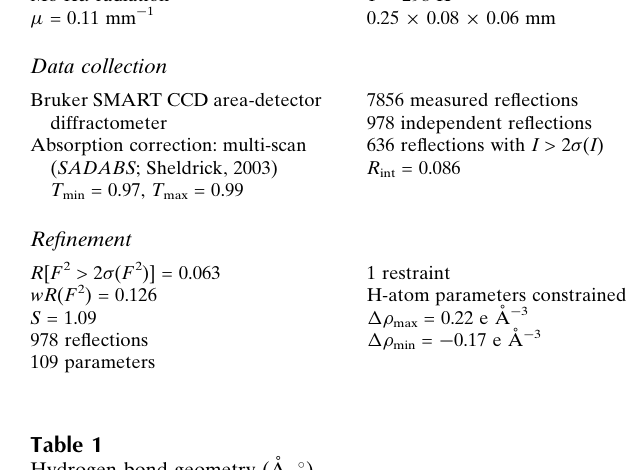
Hydrogen-bond geometry (A˚ , (cid:4)